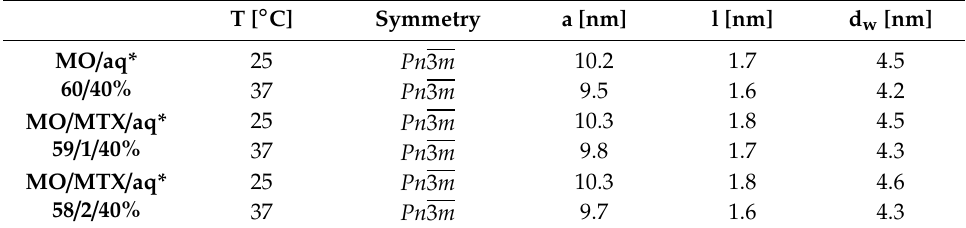
Table 1. Results of SAXS measurements for the monoolein cubic phase with and without the drug: phase symmetry, lattice parameter a , lipid length l , and water channel diameter d w .